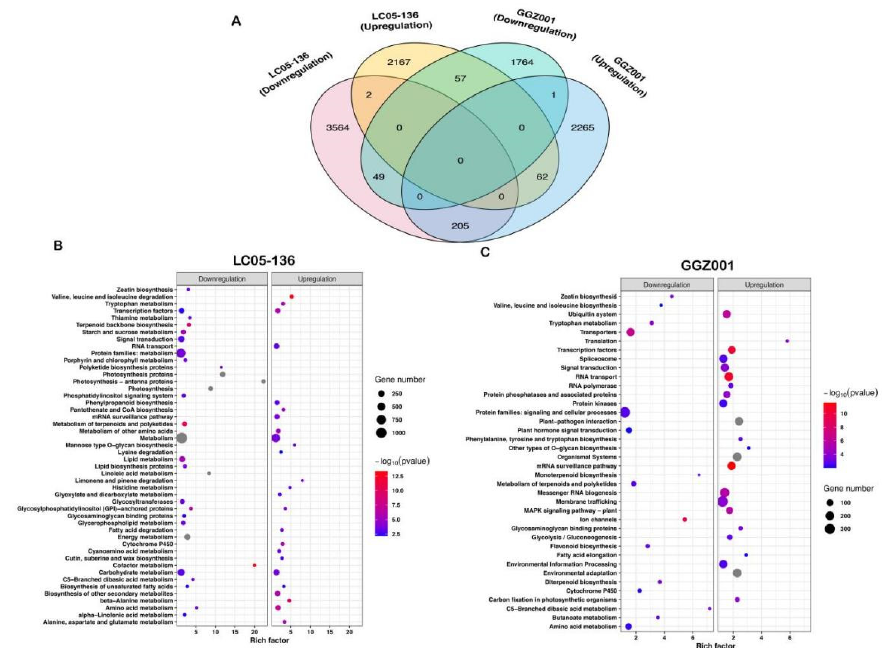
Figure 6. KEGG pathway classification and functional enrichment of DEGs. ( A ) Venn diagrams of DEGs assigned to KEGG pathways in two sugarcane cultivars treated by PBZ. The upregulated DEGs of LC05 − 136 and GGZ001 are shown in yellow and blue, respectively; the downregulated DEGs of LC05 − 136 and GGZ001 are shown in pink and green, respectively. ( B ) Pathway functional enrichment of up − and downregulated DEGs in LC05 − 136. ( C ) Pathway functional enrichment of up − and downregulated DEGs in GGZ001.